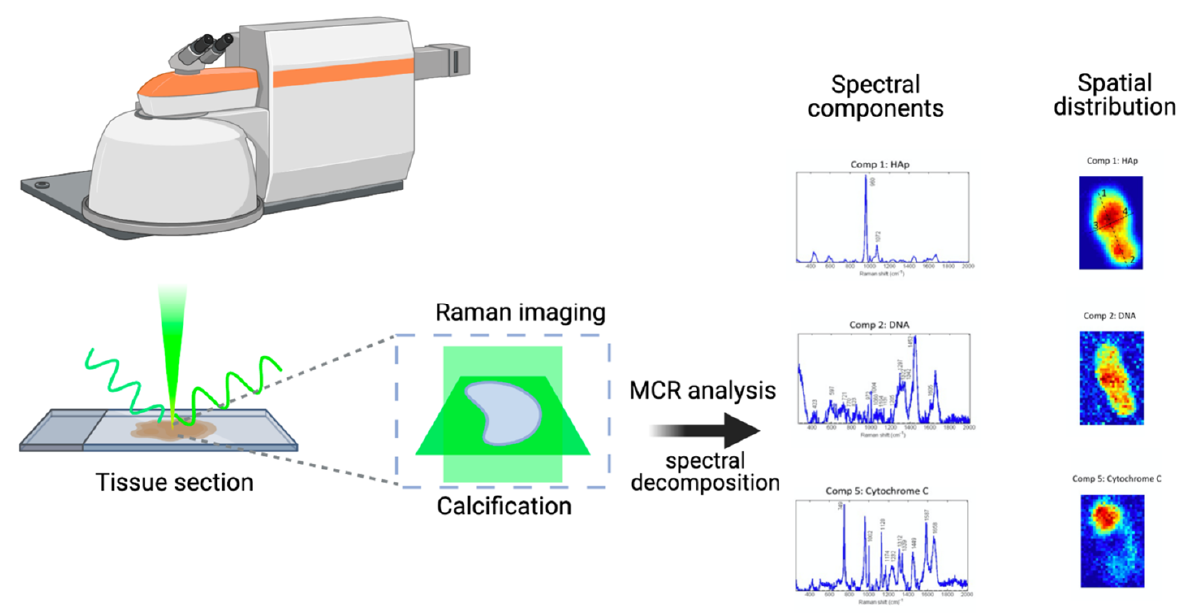
Figure 1. Workflow and experimental design: in this paper, we demonstrate a methodology that is capable of investigating the biochemical composition of HAp calcifications in human breast cancer tissues. First, we perform Raman imaging of breast cancer tissue sections ( n = 26 patients), acquiring 2D images in perpendicular directions (xy, xz and yz) in order to retrieve 3D molecular information. Second, we use an advanced multivariate analysis method, multivariate curve resolution (MCR) to extract otherwise inaccessible molecular information encoded in the Raman spectra. Specifically, we decompose several spectral components, corresponding to organic molecules and their associated 3D molecular spatial distribution in HAp microcalcifications. Through this method, we show the presence and 3D spatial distribution of several molecular components (DNA, lipids, proteins, cytochrome C and polysaccharides) in the HAp calcifications extracted from cancer tissues.